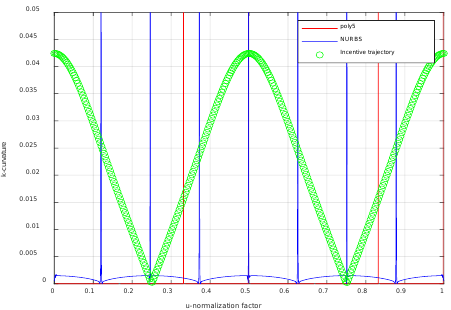
Figure 13. Curvature graph of NURBS and five-degree polynomial planning algorithms.